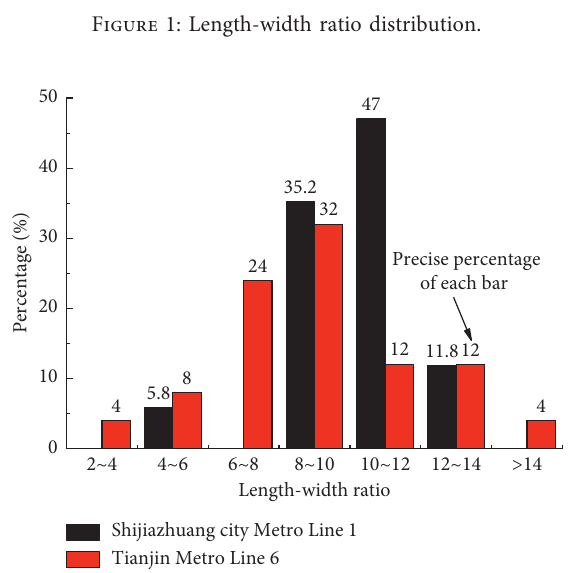
Figure 4: Distribution of maximum lateral movement of foun- dation pit retaining structures.